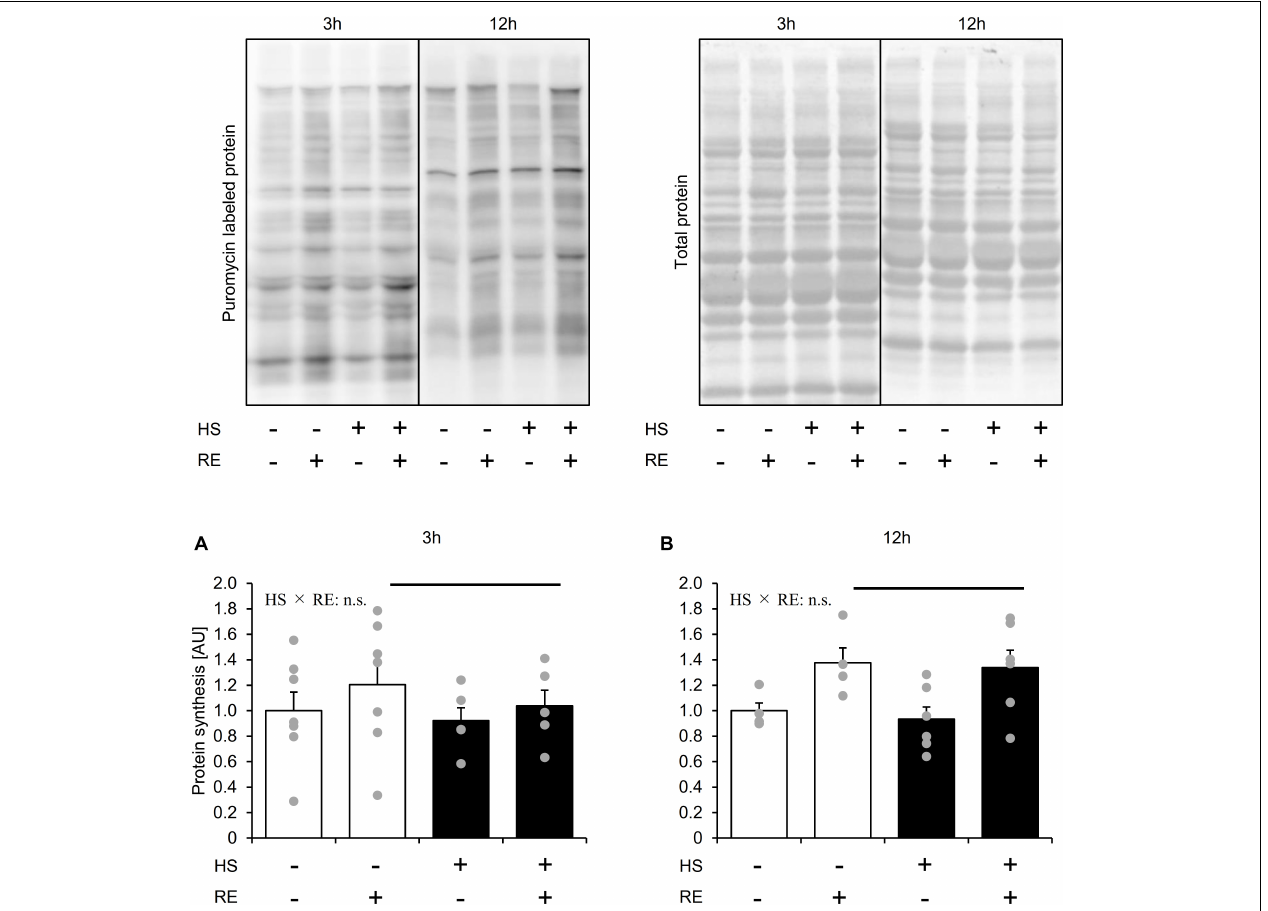
FIGURE 3 | The effect of acute RE on muscle protein synthesis after 14 days of hindlimb suspension (A,B) . HS: hindlimb suspension. RE: acute resistance exercise. 3 h: 3-h after exercise. 12 h: 12-h after exercise. Values are means ± SE ( n = 5–6/group). Black line: main effect of RE ( p <